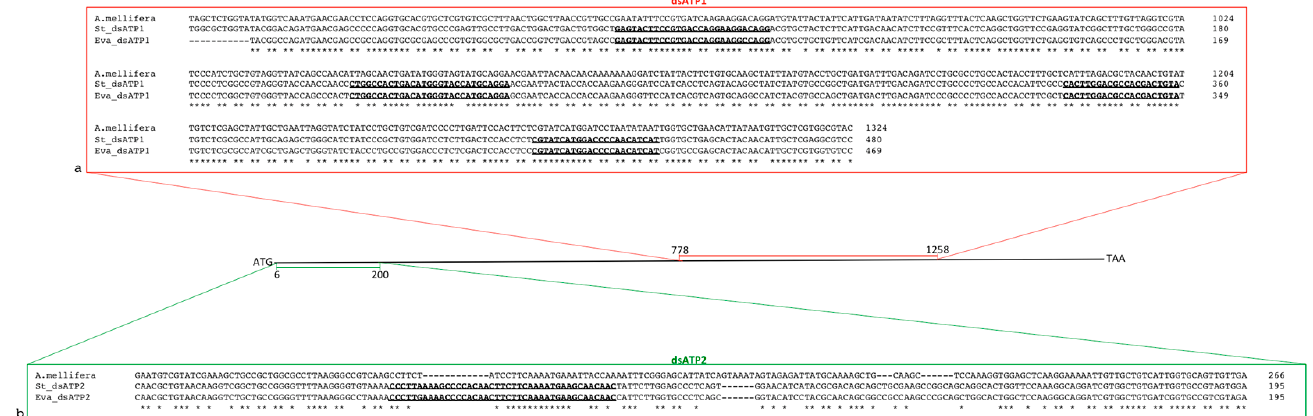
Figure 6. Transcript level of ATP synthase β in Euscelidius variegatus injected with different doses and different dsRNA constructs. Transcript level of ATP synthase β in insects injected with 80 ( a , b ) and 8 ( c , d ) ng/insect of dsRNAs targeting green fluorescent protein (dsGFP) or ATP synthase β of E. variegatus (Eva_dsATP1, Eva_dsATP2) and of Scaphoideus titanus (St_dsATP1 and St_dsATP2), collected and analyzed at seven ( a , c ) and 15 ( b , d ) days post injection (dpi). Within the same date and dose, different letters indicate significant differences in transcript levels (ANOVA, followed by Holm–Sidak method). The median of five to seven samples is shown as a line across each box, the box indicates the 25th and 75th percentiles and whiskers represent the 90th and 10th percentiles. Silencing of ATP synthase β with the newly designed dsRNAs (Eva_dsATP2, St_dsATP1 and St_dsATP2) caused the alteration of ovaries and the absence/reduction in collected offspring from injected parental E. variegatus adults (Figure 7 and Table 3).